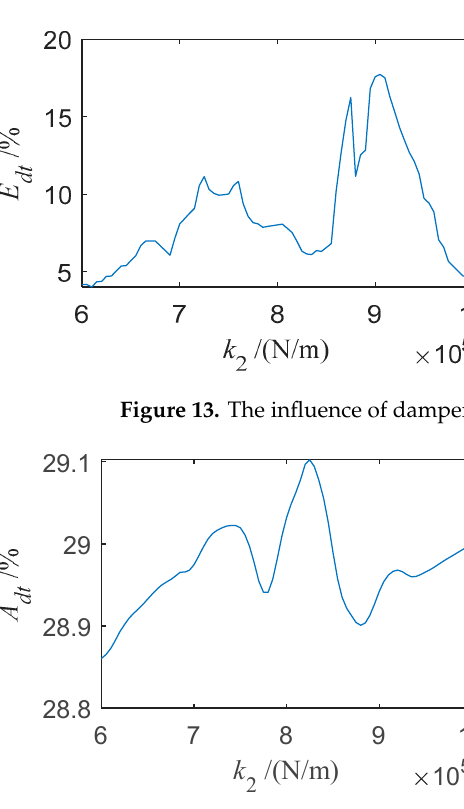
Figure 14. The influence of damper stiffness on the reduction of maximum absolute value of vibrational response.